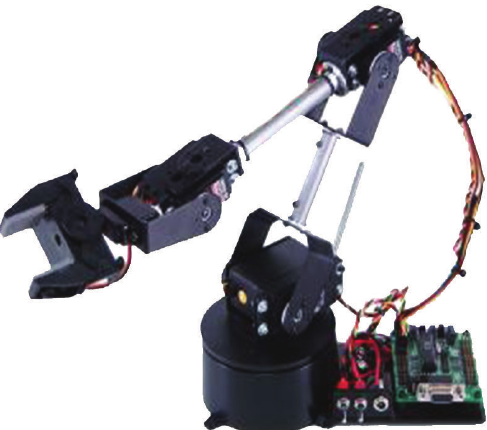
Figure 3: AL5C arm from Lynxmotion, Inc.